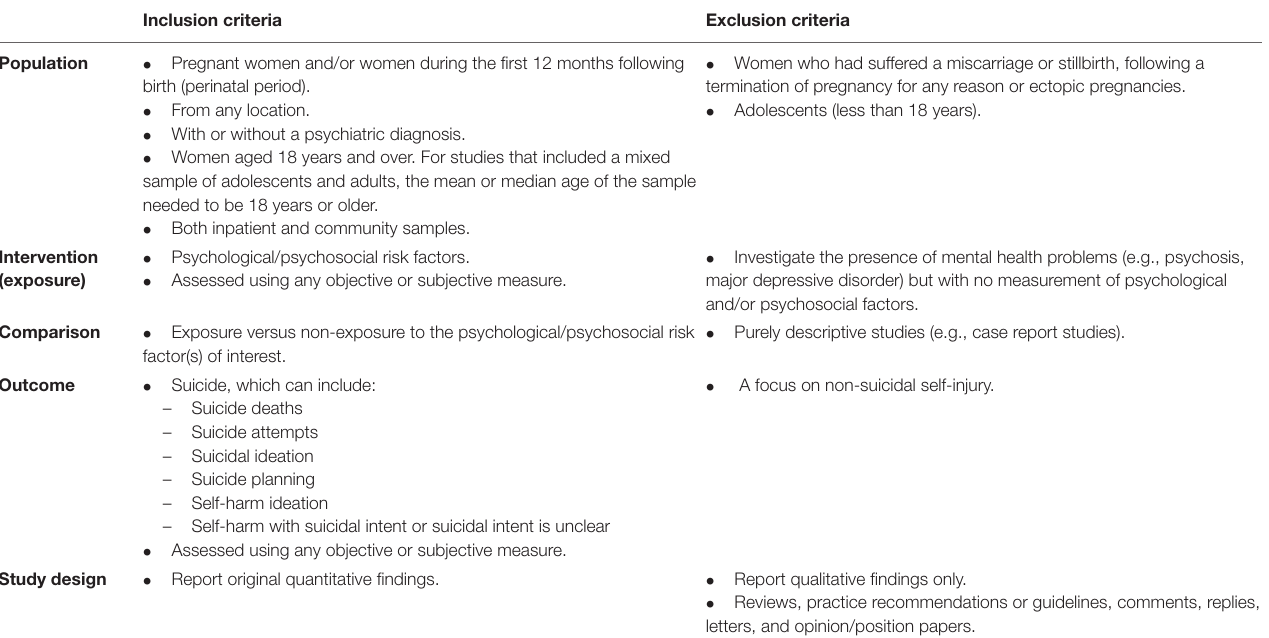
TABLE 1 | Eligibility criteria for inclusion of studies in the